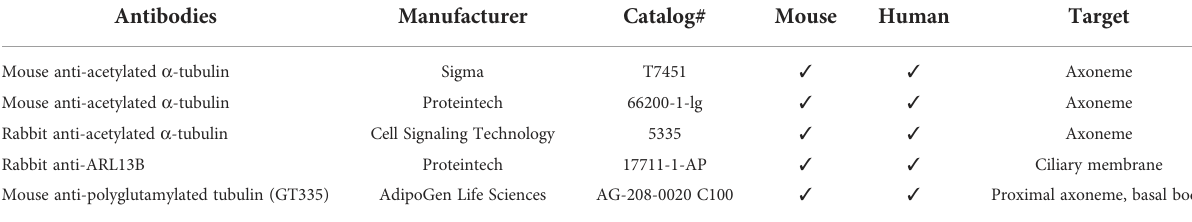
TABLE 1 Recommended antibodies for islet cilia staining.